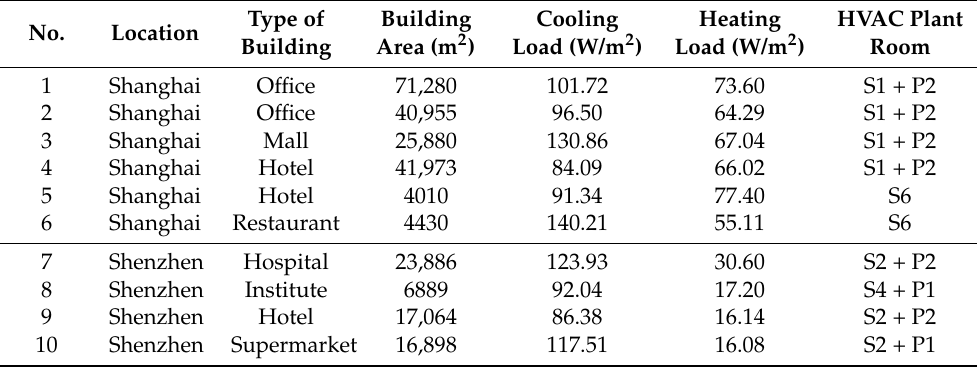
Table 6. Ten real building cases and their basic